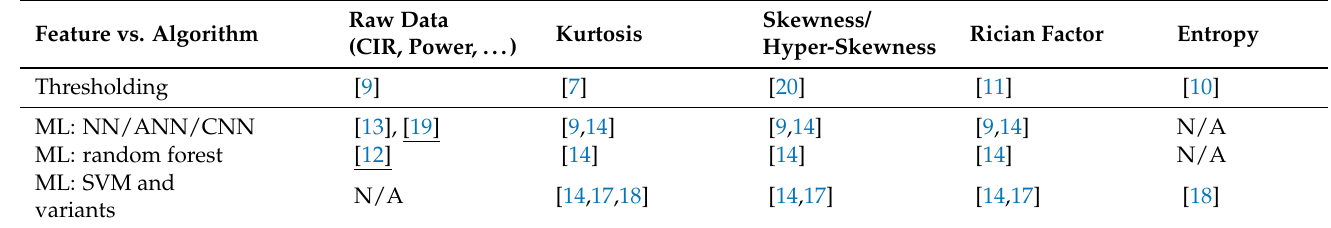
Table 1. Feature-algorithm combinations used in the literature for LOS detection in various wireless systems; those also analyzed in a 5G context are shown underlined. N/A = not available. Raw Data Skewness/ Feature vs. Algorithm Kurtosis Rician Factor Entropy (CIR, Power, ...)